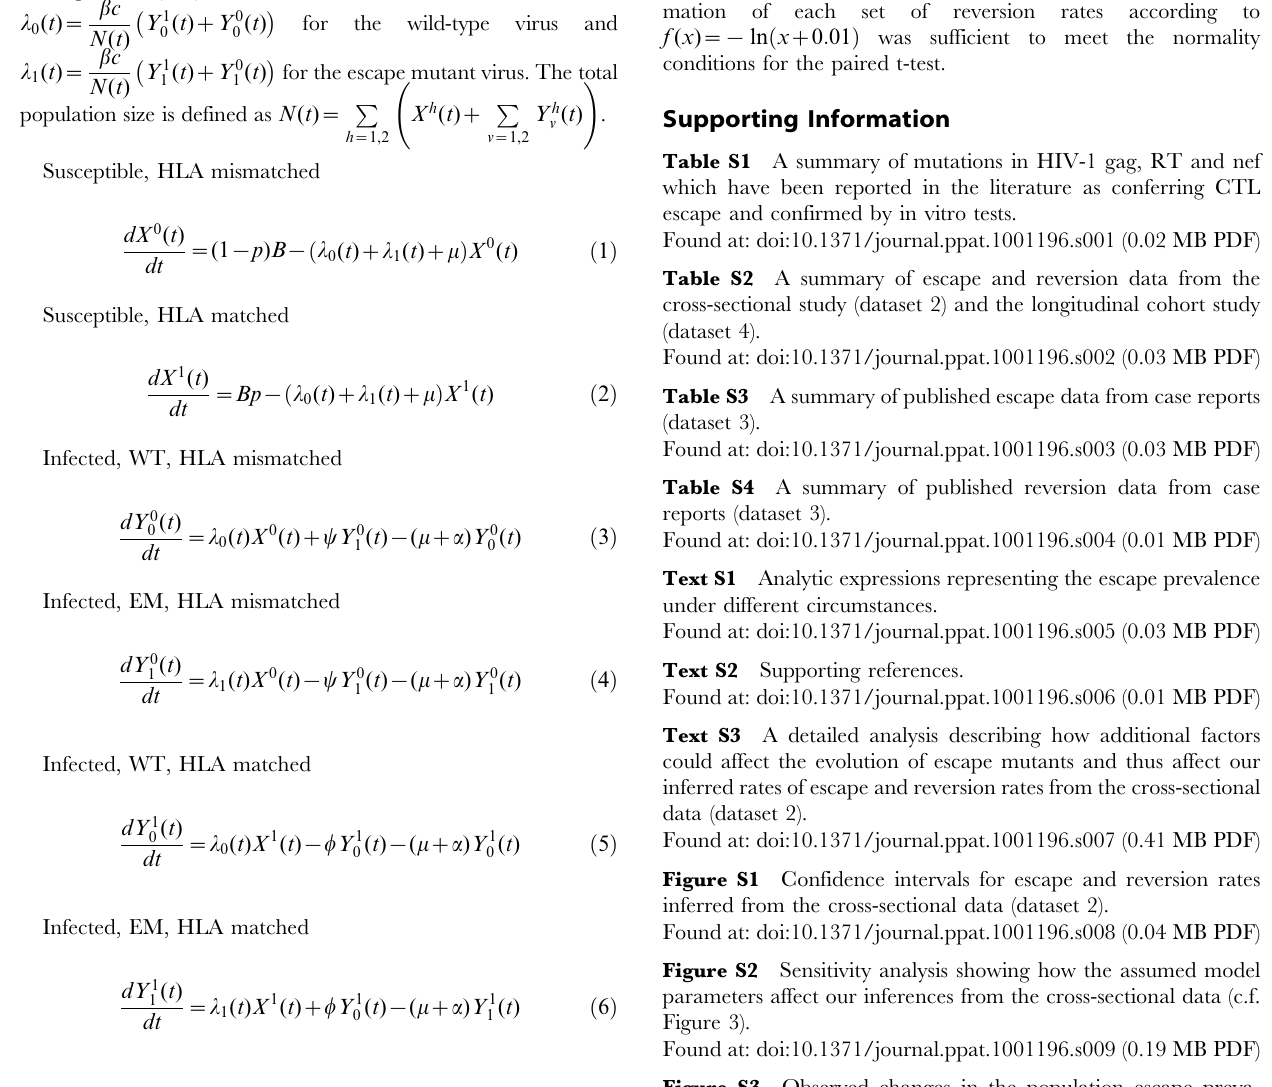
Figure S1 Confidence intervals for escape and reversion rates inferred from the cross-sectional data (dataset 2). Figure S2 Sensitivity analysis showing how the assumed model parameters affect our inferences from the cross-sectional data (c.f. Figure 3). Figure S3 Observed changes in the population escape preva- lence over approximately 20 years (dataset